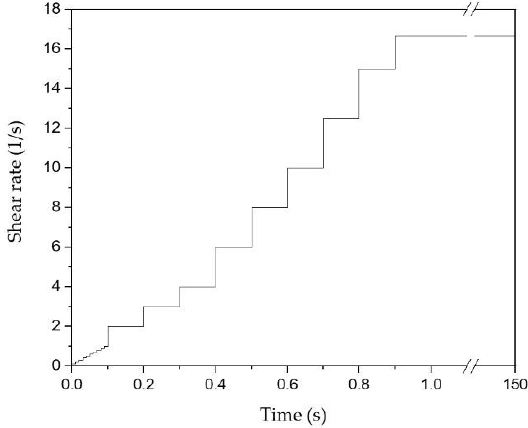
Figure 9. Stepwise increase profile of shear rate for fiber relaxation.